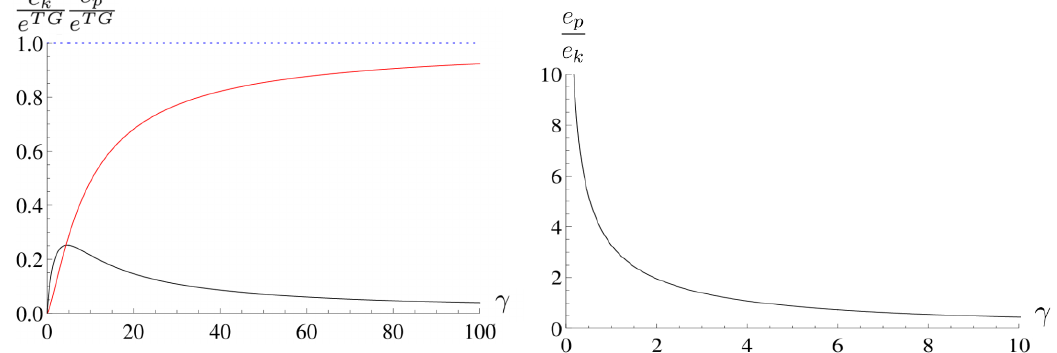
Figure 4: Left panel: dimensionless ground-state kinetic energy per particle (red) and inter- action energy per particle (black), normalized to the total energy per particle in the Tonks- Girardeau limit e TG , as a function of the dimensionless interaction strength γ . The horizontal line (blue, dotted) is a guide to the eye. Right panel: dimensionless ratio of the interaction and kinetic energy as a function of γ .